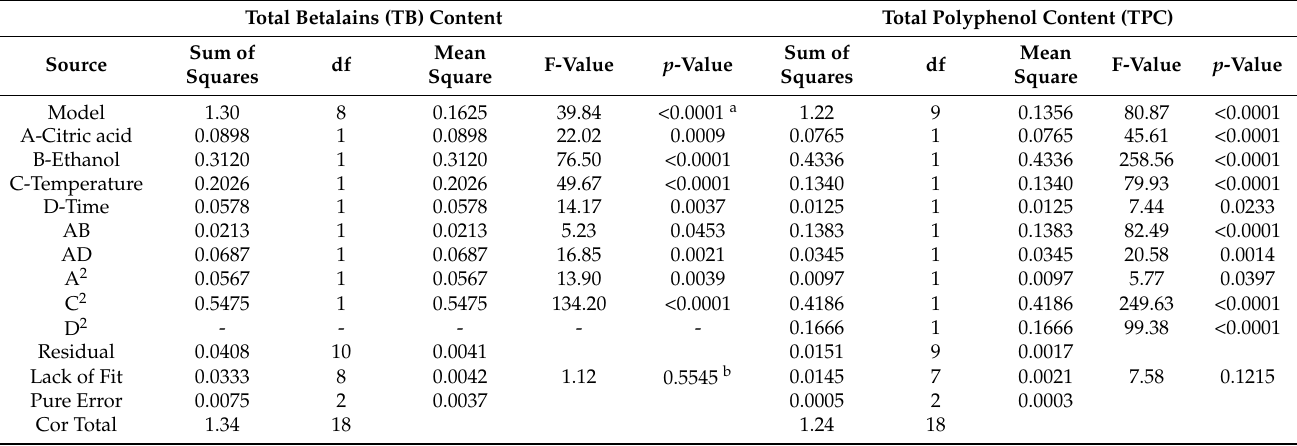
Table 3. ANOVA for the reduced quadratic model for BT and TPA extractions.